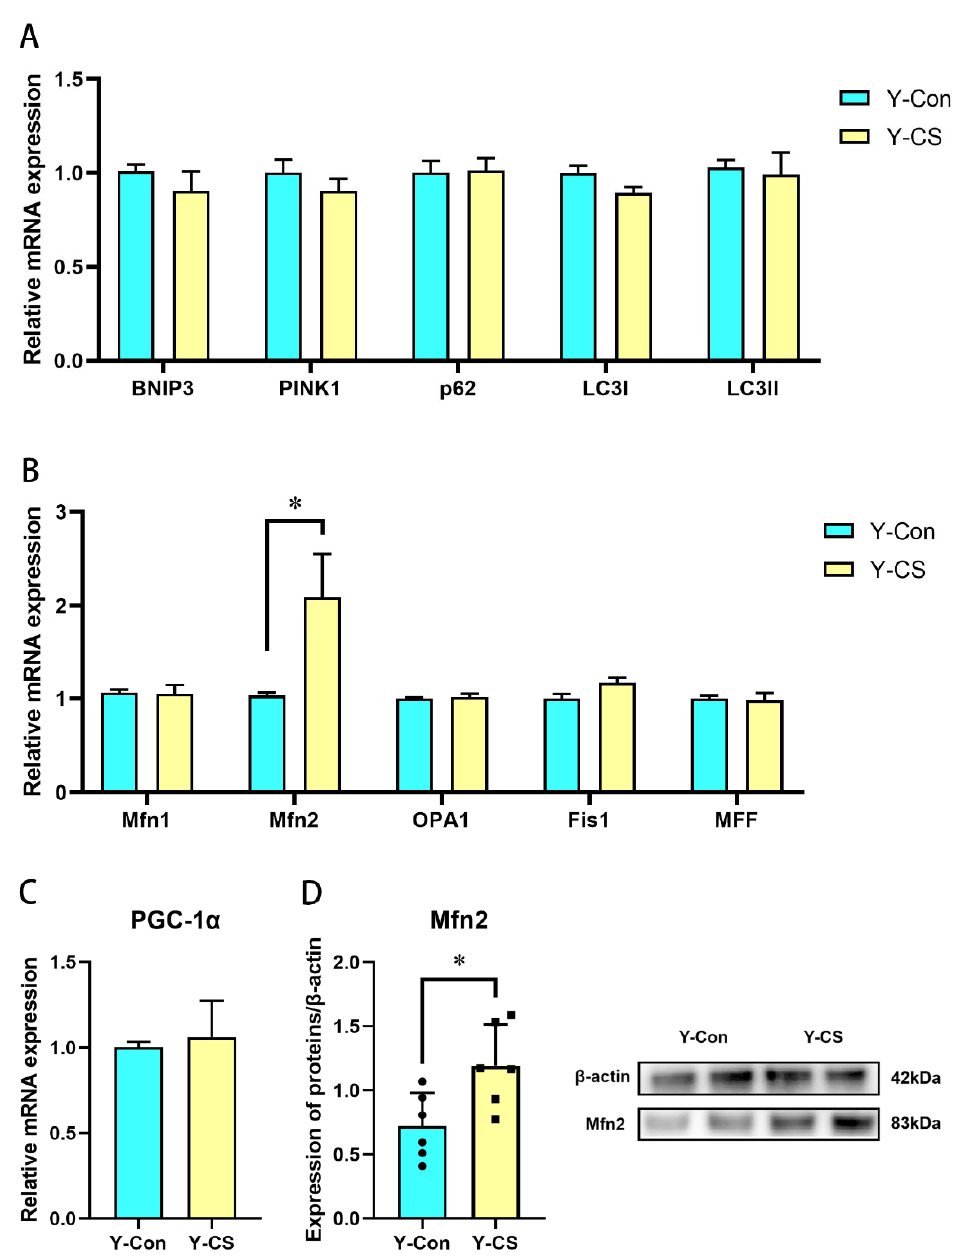
Figure 4. Chronic cold exposure disrupts the mitochondrial kinetic balance in lungs. ( A ) Expression of genes related to mitochondrial autophagy. ( B ) Expression of genes related to mitochondrial dynamic balance. ( C ) PPARG coactivator 1 alpha (PGC-1 α ) mRNA expression. ( D ) Mitofusin 2 (Mfn2) protein expression. Bax protein expression. Data are expressed as the mean ± SEM, n = 6, * p < 0.05.